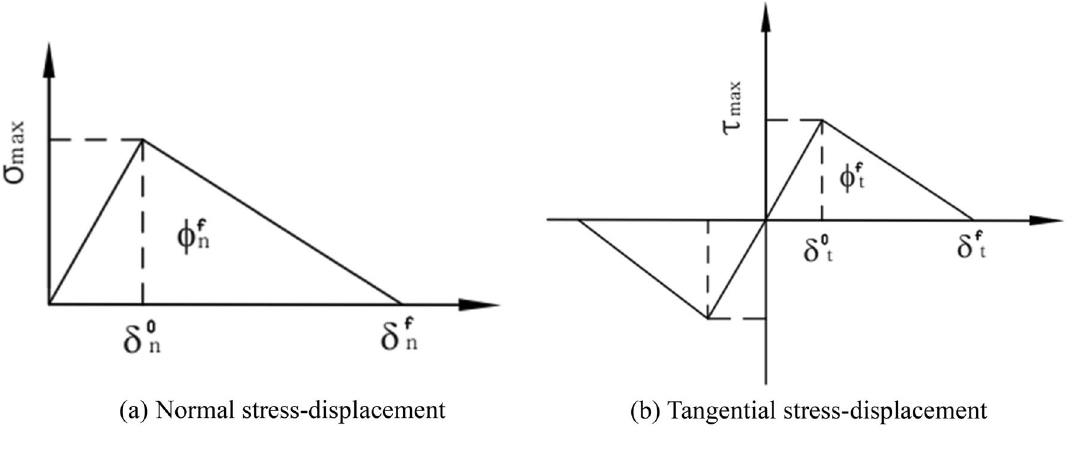
Figure 15. Cohesion